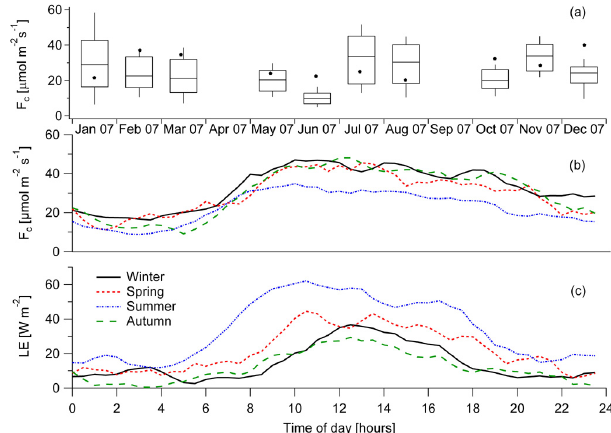
Fig. 8. (a) Monthly breakdown of CO 2 flux statistics for 2007 (bot- tom and top of boxes correspond to 25th and 75th percentiles, re- spectively; bottom and top whiskers correspond to 10th and 90th percentiles, respectively; monthly means and medians are indicated by solid markers and horizontal lines, respectively), and seasonal trends in (b) CO 2 and (c) latent heat fluxes. Winter is defined as De- cember 2006-February 2007, spring is March-May 2007, summer is June-August 2007 and autumn is September-November